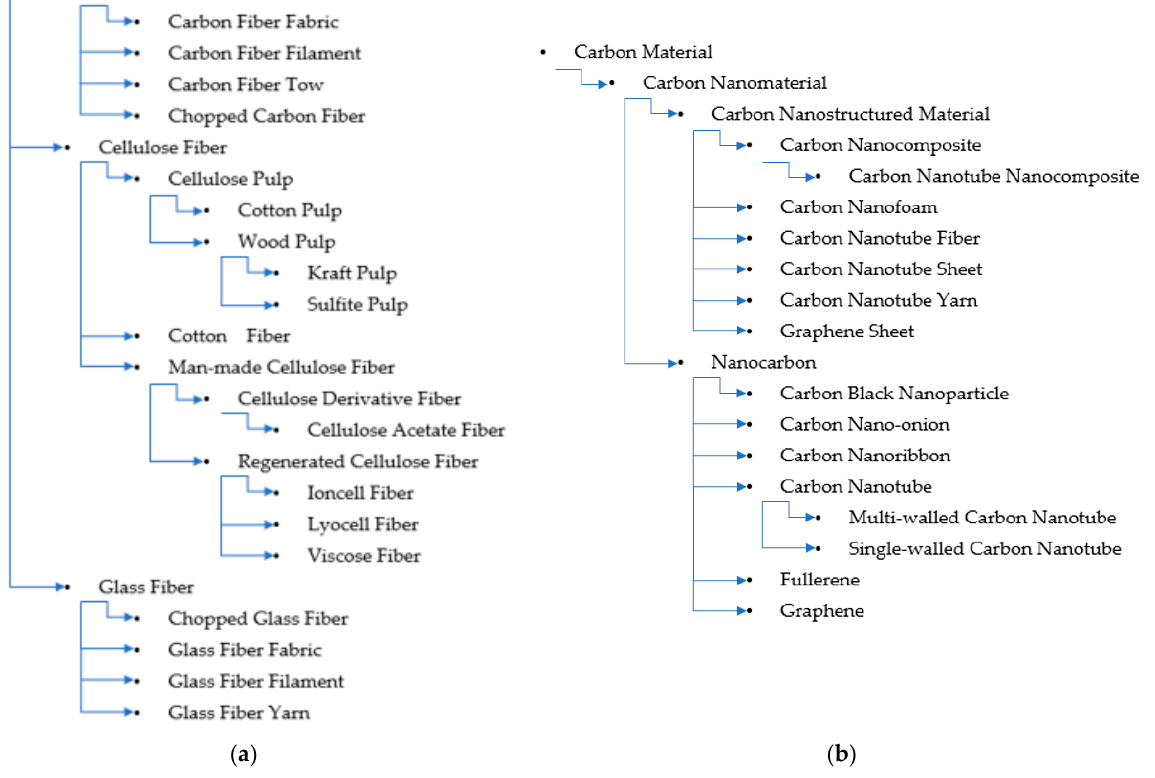
Figure 4. ( a ) Fiber taxonomies and ( b ) carbon nanomaterial classification used in this